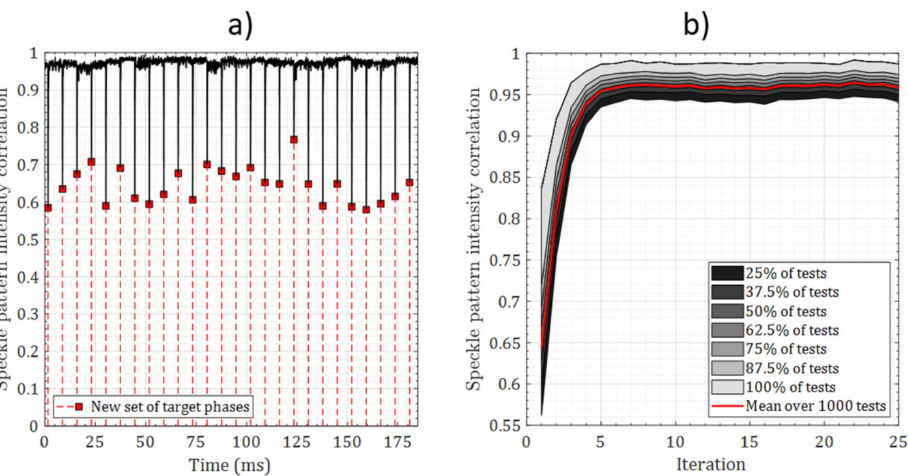
Figure 10. Experimental sequence of periodic target phase changes showing the evolution of the speckle pattern intensity correlation. Vertical scale denotes errors in the individual beams’ phase with respect to their steady state values corresponding to the desired state. ( a ) Red dotted lines mark the times of target phase changes, ( b ) same experimental sequence of data folded in a single cycle, highlighting the dynamics toward a steady state phase profile for 1000 abrupt phase changes. One iteration of the phase correction loop took 92 µ